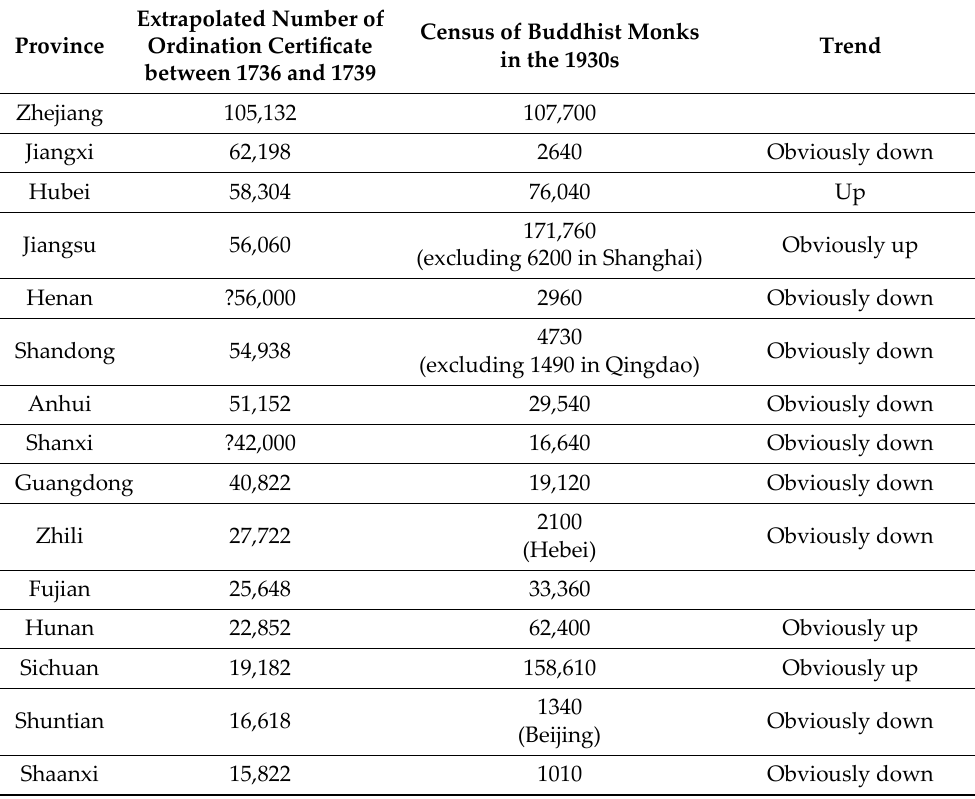
Table 9. The distributional changes of the number of monks in each province in China in the past 200 years (from the mid‑18th century to the first half of the 20th century). Extrapolated Number of Census of Buddhist Monks Province Ordination Certificate in the 1930s between 1736 and 1739